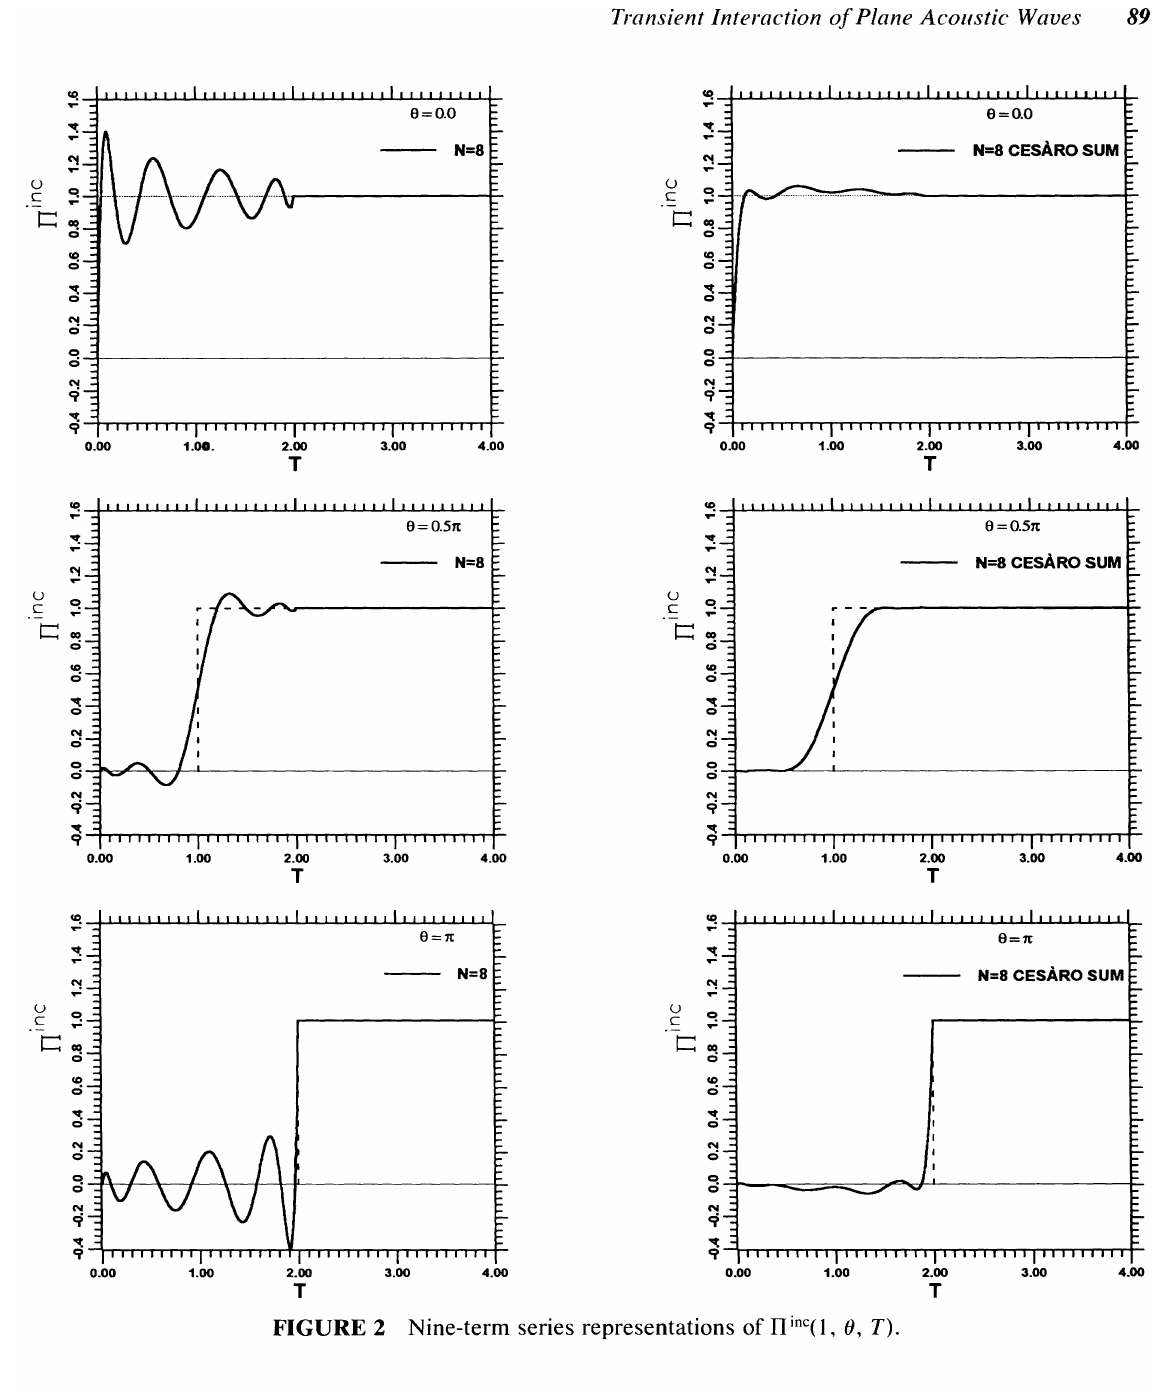
FIGURE 2 Nine-term series representations of II inc( 1, (),